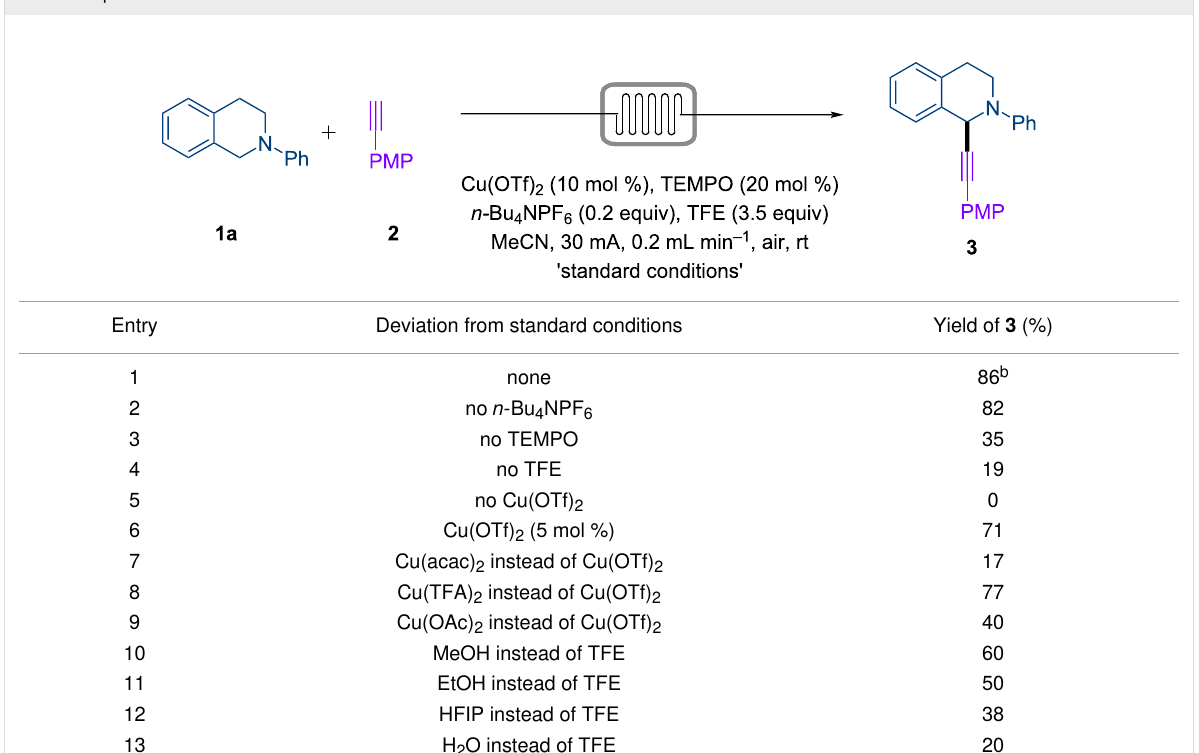
Table 1: Optimization of reaction conditions.